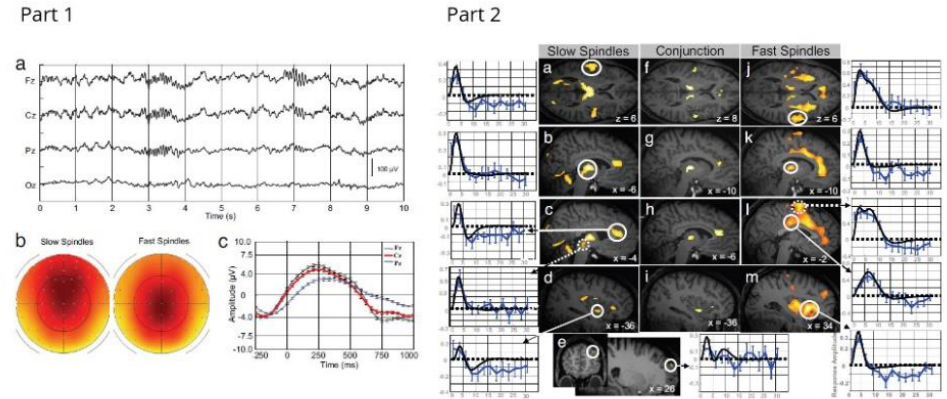
Figure 9. Part 1. EEG characterisation of sleep spindles. ( a ) Example of a typical EEG recording (stage 2 sleep; 0.1 to 70 Hz) after scanner and pulse artifact correction, depicting a fast posterior (Pz, left side) and a slow anterior (Fz, right side) spindle. ( b ) EEG scalp topography of the average spindle band power between 11–13 (left) and 13–15 Hz (right). For display, the average normalised spindle power of all slow and fast sleep spindles (detected on Cz) was computed at each channel and between 11–13 and 13–15 Hz, respectively. Slow sigma power predominates over the frontal central regions whereas fast sigma power is mainly expressed over centro-parietal areas. Nose is upwards, right is rightwards. ( c ) Spindle-triggered average revealing the underlying slow oscillation. EEG data (0.5–4 Hz) were averaged with respect to the onset of all sleep spindles. Spindles start (t 0) on the depolarising phase of the oscillation, which on average are of much smaller amplitude than the classical full blown slow waves of deep, slow-wave sleep. The classical phase lag from frontal (Fz, black) to central (Cz, red) and parietal (Pz, blue) areas and the maximal slow wave amplitude at the frontal recording site are also depicted. Part 2. Main effects of slow and fast sleep spindles. ( a – e Left) fMRI responses to slow spindles displayed over an individual structural image normalised to the Montreal Neurological Institute space (P uncorrected < 0.001). The leftmost panels show peristimulus time histograms (PSTHs) depicting the responses in auditory cortices (circled) ( a ), thalamus ( b ), anterior cingulate (circled) and midbrain tegmentum (dotted) ( c ), anterior insula ( d ), and superior frontal gyrus ( e ). The PSTH (solid blue line; blue error bars reflect the SEM) depicts the mean response across spindles of the corresponding voxel, irrespective of contrast based on a finite impulse response refit. The fitted response is drawn in black. ( f – i Centre) Conjunction analysis of slow and fast sleep spindles. ( j – m Right) fMRI responses to fast spindles (P uncorrected < 0.001). The right most panels show PSTHs depicting the response in superior temporal gyri ( j ), thalami ( k ), mid cingulate cortex (circled) and SMA (dotted) ( l ), and anterior insula ( m ). Reproduced from Ref. [129]. Copyright 2007 National Academy of Sciences.